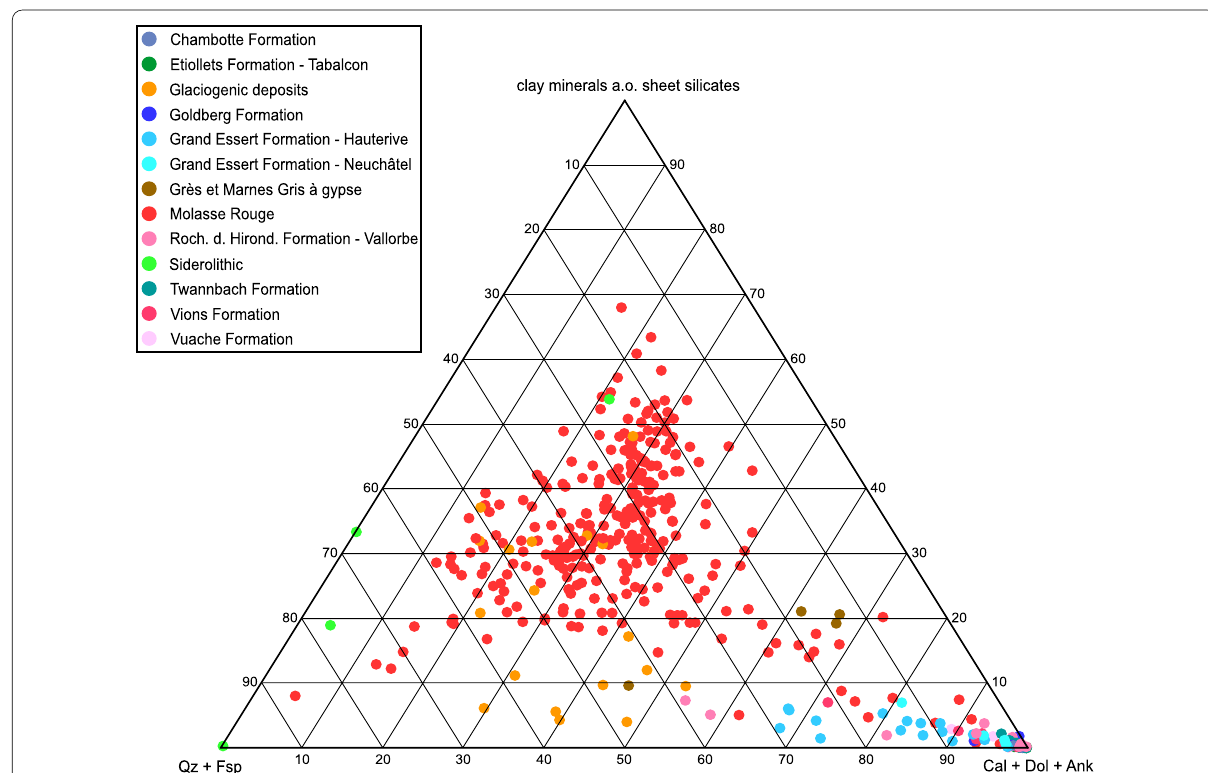
Fig. 7 Lithotypes for wells Montfleury-2 and L112 as well as outcrops Mornex, Biollay, Nyoux and Sarzin-R for various geological formations encountered in the Geneva Basin based on QEMSCAN measurements. Mineral abbreviations: Qz quartz, Fsp feldspar, Cal calcite, Dol dolomite, Ank